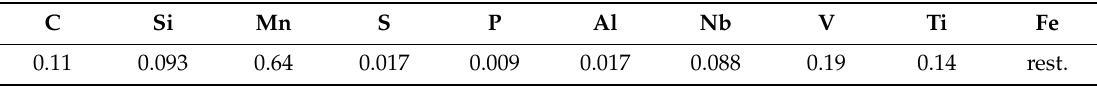
Table 1. Chemical composition of the experimental material Strenx 700 MC (wt.%) obtained by optical emission spectroscopy